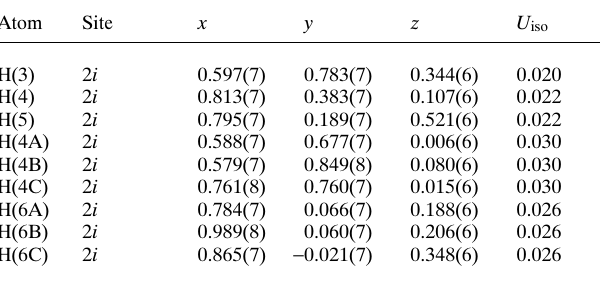
Table 2. Atomic coordinates and displacement parameters (in Å 2 )